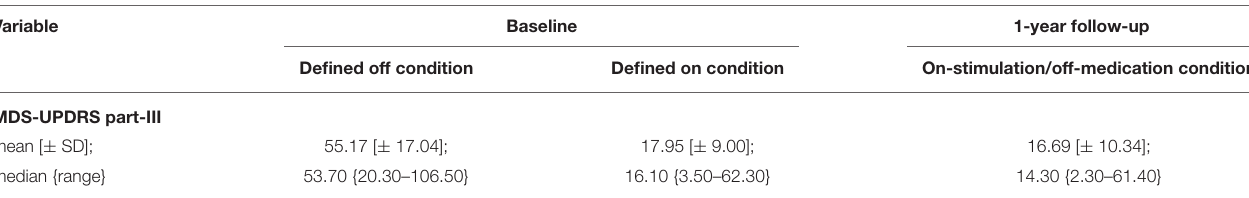
TABLE 2 | Changes in the MDS-UPDRS part III score 1 year after STN-DBS surgery ( n = 233). Variable Baseline 1-year follow-up Defined off condition Defined on